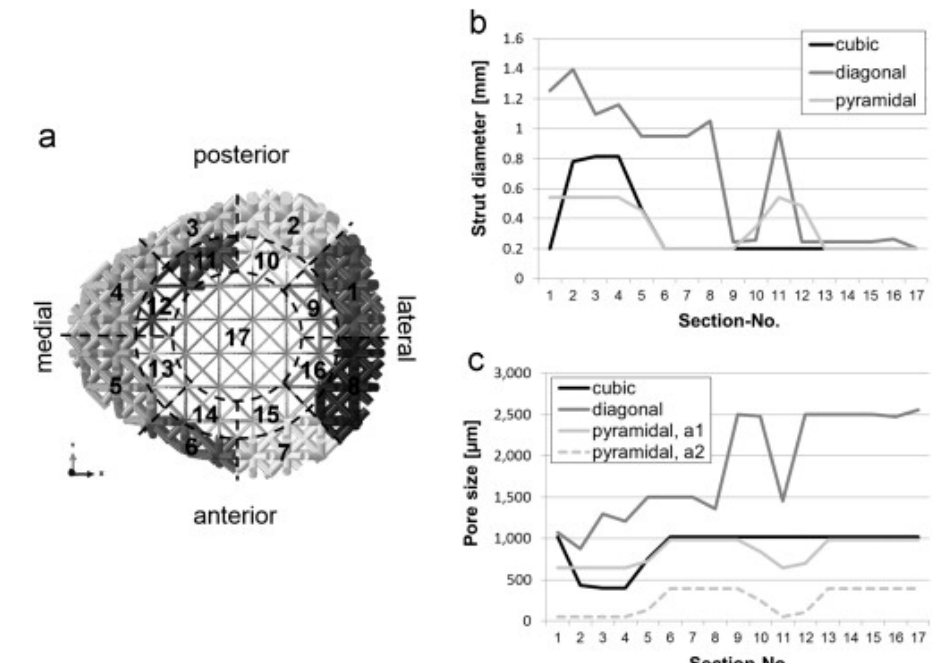
Figure 4. Distribution of the strut diameter of the 17 sections for the biomechanically optimized scaffolds with diagonal design ( a ); results in terms of strut diameter ( b ); and pore size ( c ) of each section for all the three investigated scaffold designs [100].